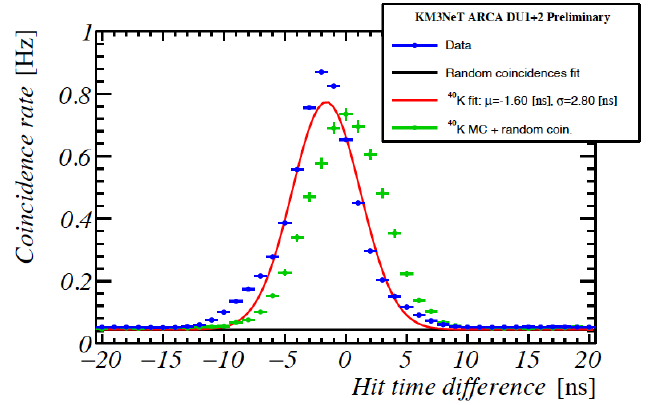
Figure 1: Coincidence rate vs ∆ t for a pair of ad- jacent PMTs. Blue dots represent uncalibrated data. The red line is a Gaus- sian fit with mean equal to − 1 . 6 ns and standard devi- ation equal to 2.8 ns. The green points show the ex- pected hit time di ff erence corrected with the addition of the background rate es- timated from the tail of the data distribution (black solid line) [3].